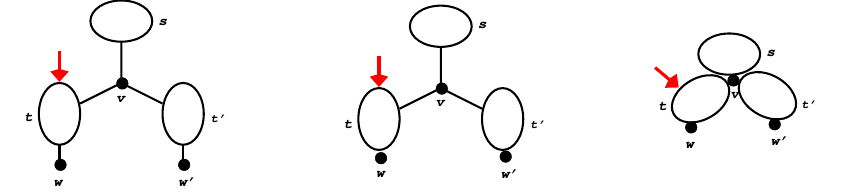
Figure 1. Graphical representations of a